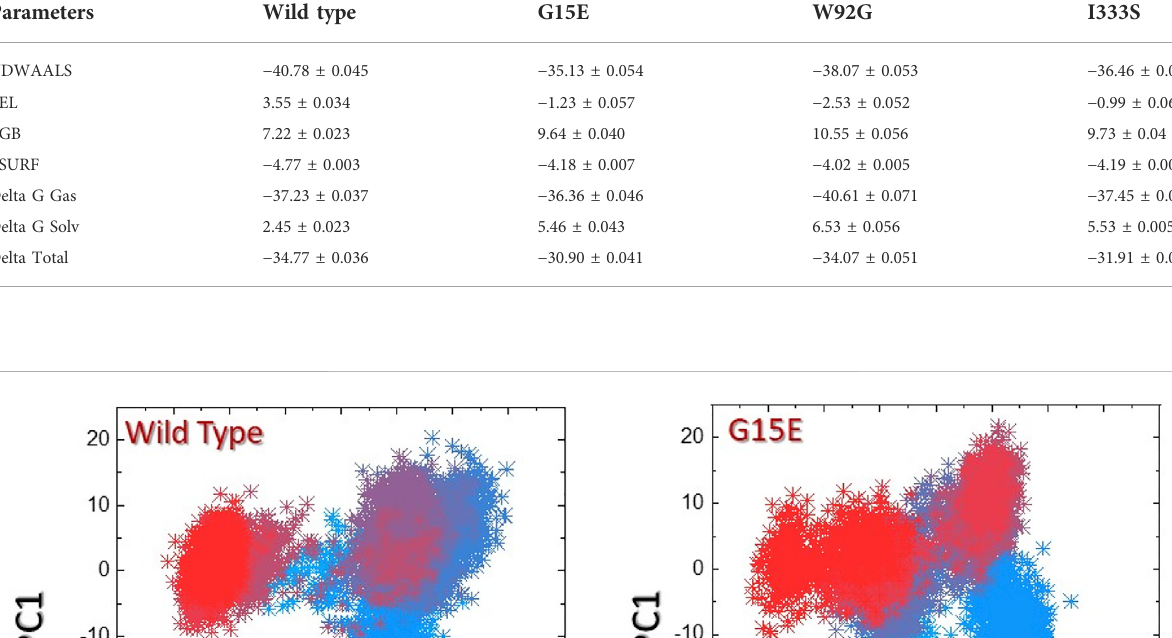
TABLE 3 Total binding free energy for the wild-type, G15E, W92G, and I333S complexes. All of the values are calculated in kcal/mol. Parameters